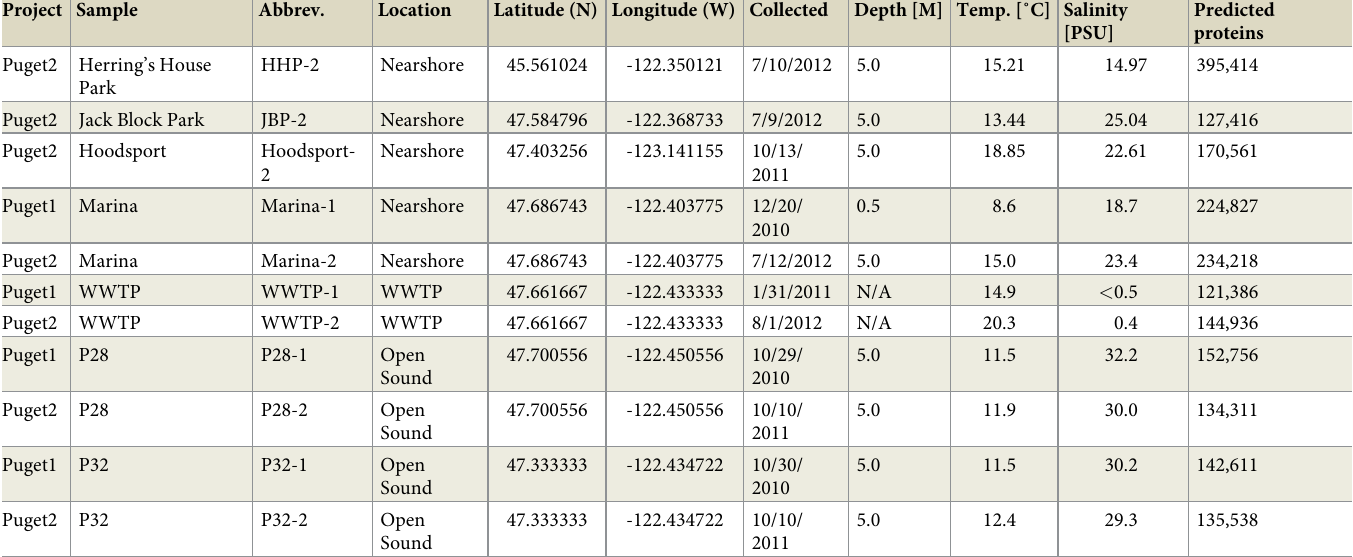
Fig 1. Map of sample sites for Puget1 and Puget2 projects. https://doi.org/10.1371/journal.pone.0192412.g001 Table 1. Environmental metadata for 11metagenomic